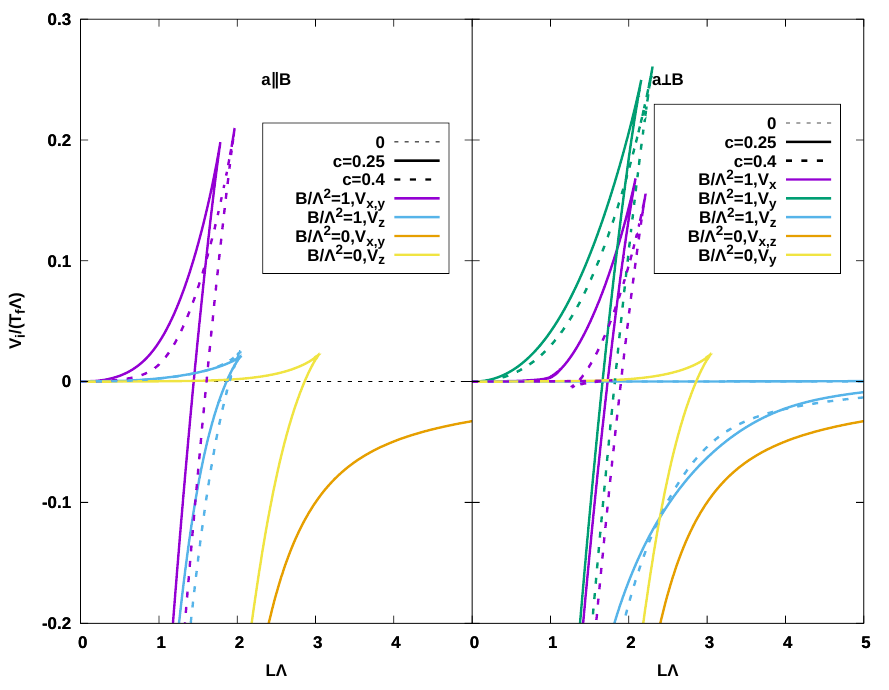
Figure 11 . Quark-antiquark potential in the presence of anisotropy and magnetic field, for a = 1 and B = 1 (in units of Λ ∼ 1 GeV). The magnetic field B is aligned along the z -direction while the anisotropic deformation is introduced along the z - or y -direction (parallel and perpendicular configurations, respectively). The solid lines depict results for c = 0 . 25 , which we have kept for comparison, while dashed lines show the corresponding results for c = 0 . 4 . We find the same qualitative features in both cases, perhaps with the only difference that the increase in c pushes the transition to slightly higher values of the separation, making the bound states a bit more